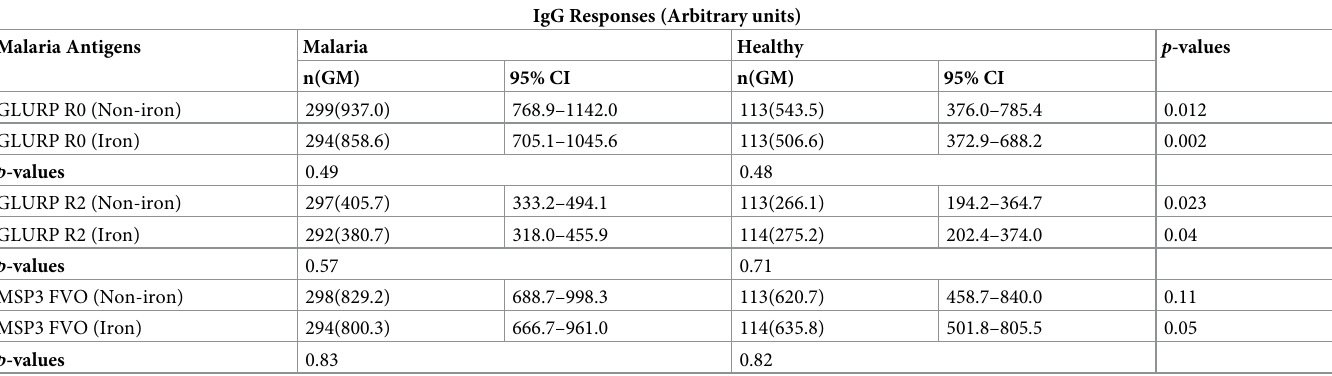
Table 4. Antigen-specific IgG responses between malaria and healthy participant.